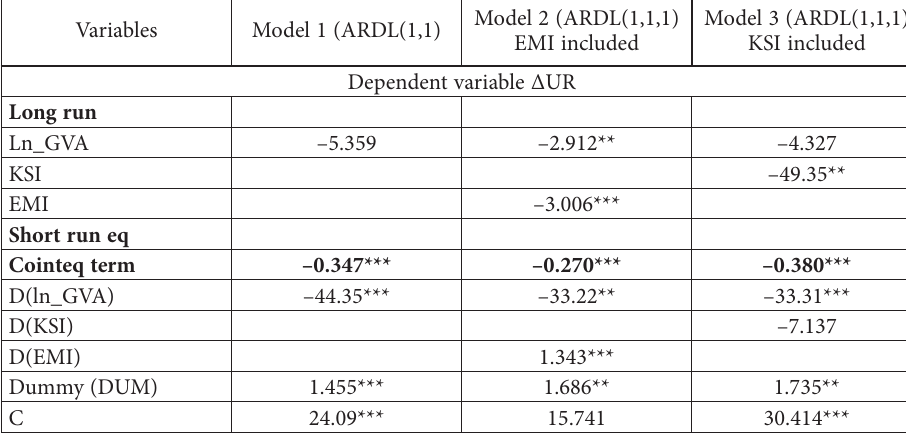
Table 8. Panel analysis results for in Public Administration, Community, Social and other Services and Activities (ADM)